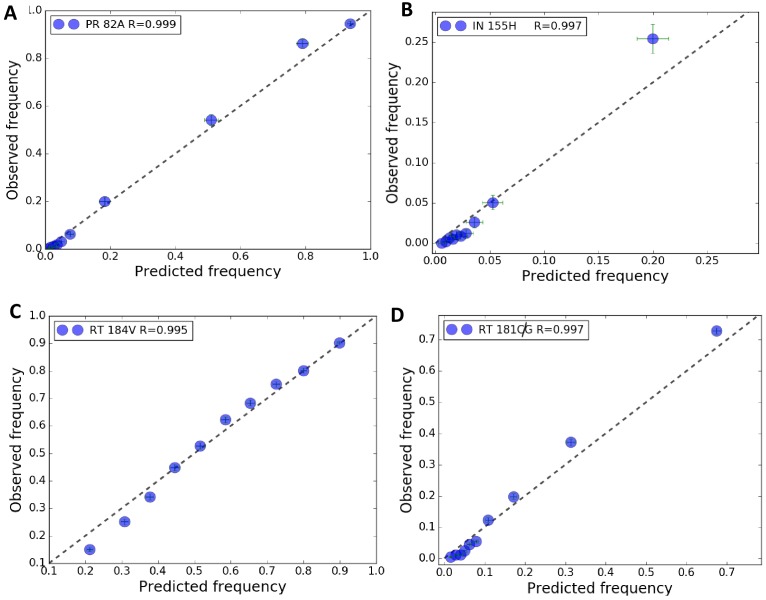
Observed vs predicted frequencies for calculating the average absolute error in Figure 1D.The average absolute error in Figure 1D is calculated by binning the sequences in ascending order of their predicted frequencies such that there are roughly equal number of sequences in each bin, and averaging the absolute error of the bins. This binning procedure avoids finite sampling errors encountered when following a more restrictive method of binning by Potts frequencies from 0 to 1 in steps of 0.1 as shown in Figure 1B especially when the mutation frequency is small. The observed vs predicted frequencies are shown for primary drug-resistance mutations V82A occurring in response to PIs in HIV-1 protease (A); N155H occurring in response to INSTIs in HIV-1 IN (B); M184V occurring in response to NRTIs in HIV-1 reverse transcriptase (C); and Y181C/G occurring in response to NNRTIs in HIV-1 reverse transcriptase (D). Diameters of the blue circles represent data sizes in each bin, and error bars are shown as green cross-hairs.